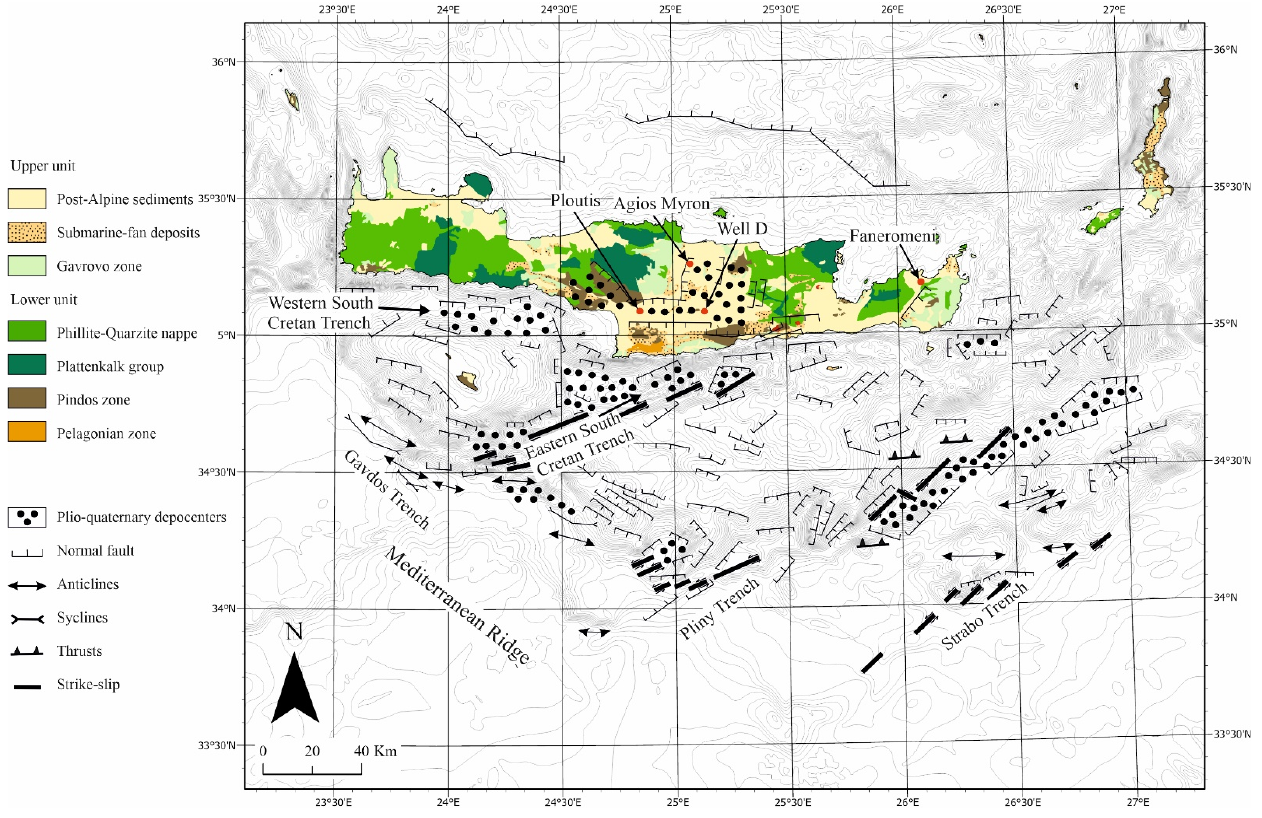
Figure 2. Scheme illustrating the tectonic zonation and main structural elements and depocenters of Crete Island and surrounding regions. Red cycles correspond to the sampling locations.